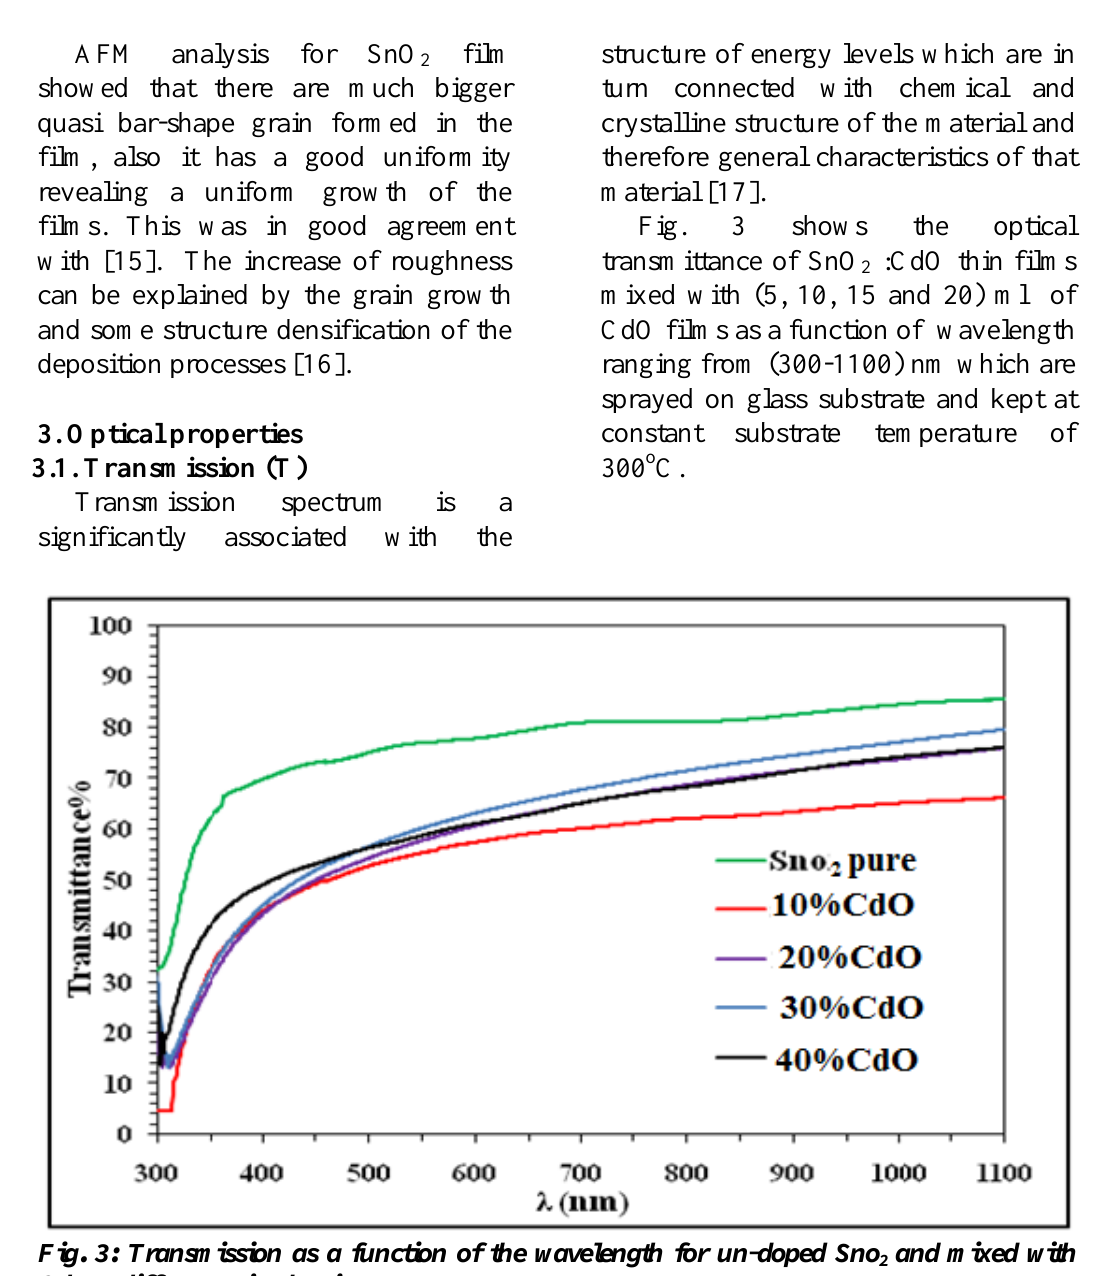
and mixed with 2